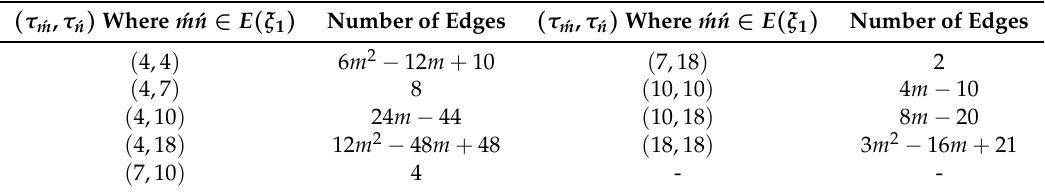
Table 5. Edge partition of the third type of rectangular hex-derived network, RHDN 3 ( m ) based on degrees of end vertices of each